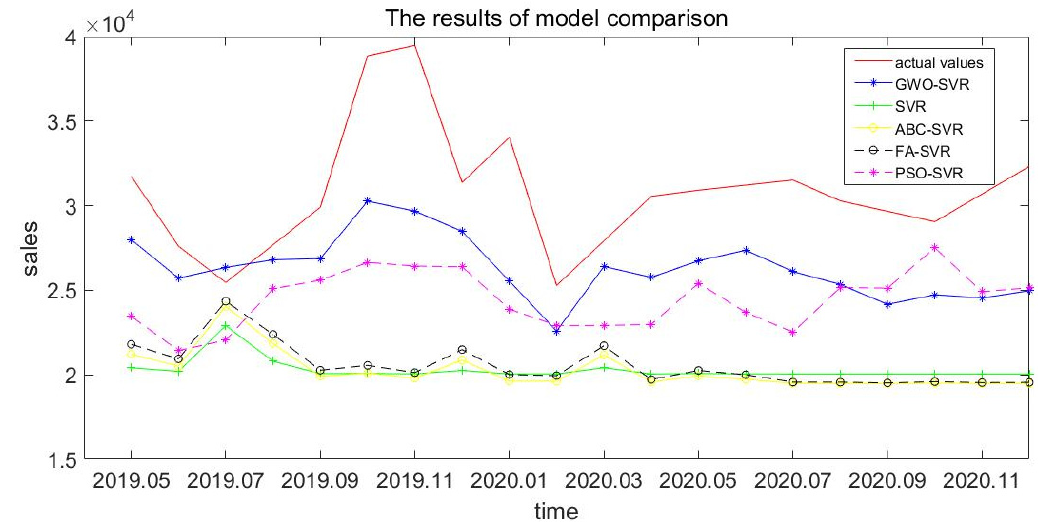
Figure 6. Model comparison results of Kaluola.